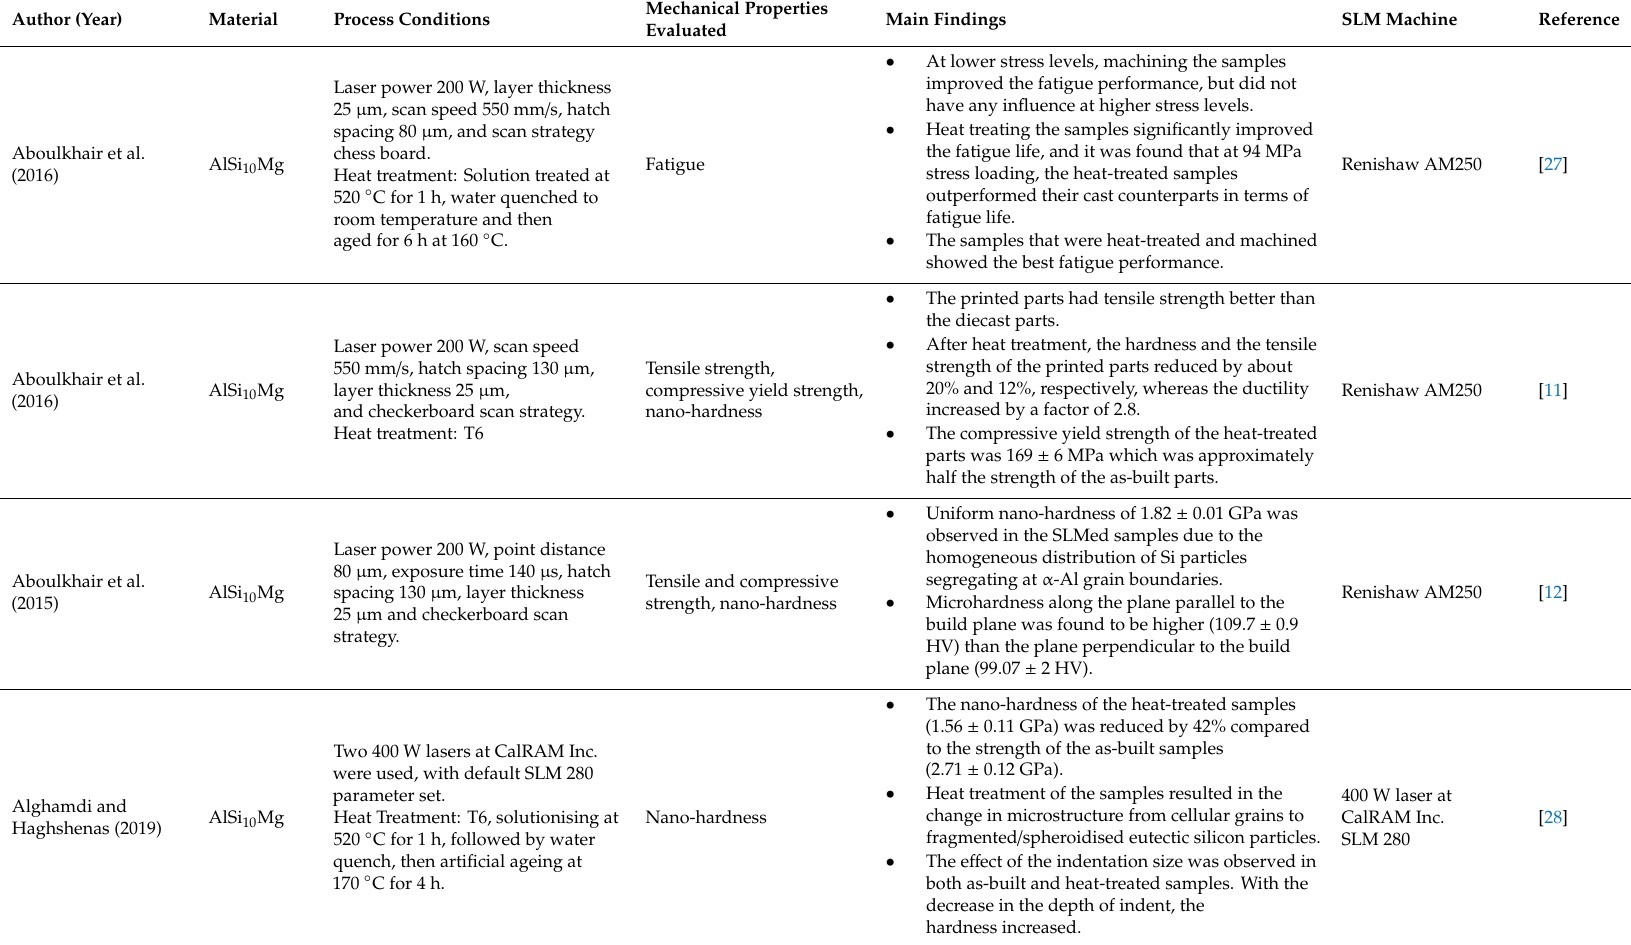
Table 1. List of published literature on SLM of aluminium